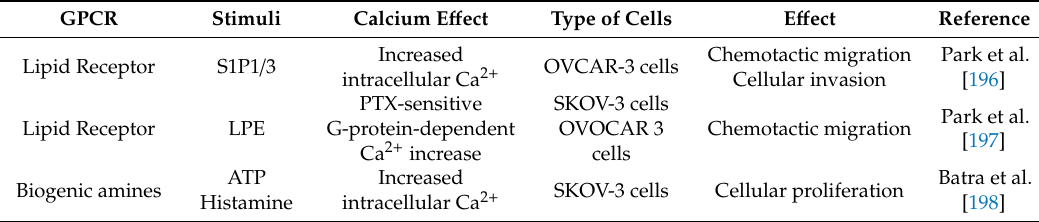
Table 3. GPCRs involved in ovarian cancer and Ca 2 +